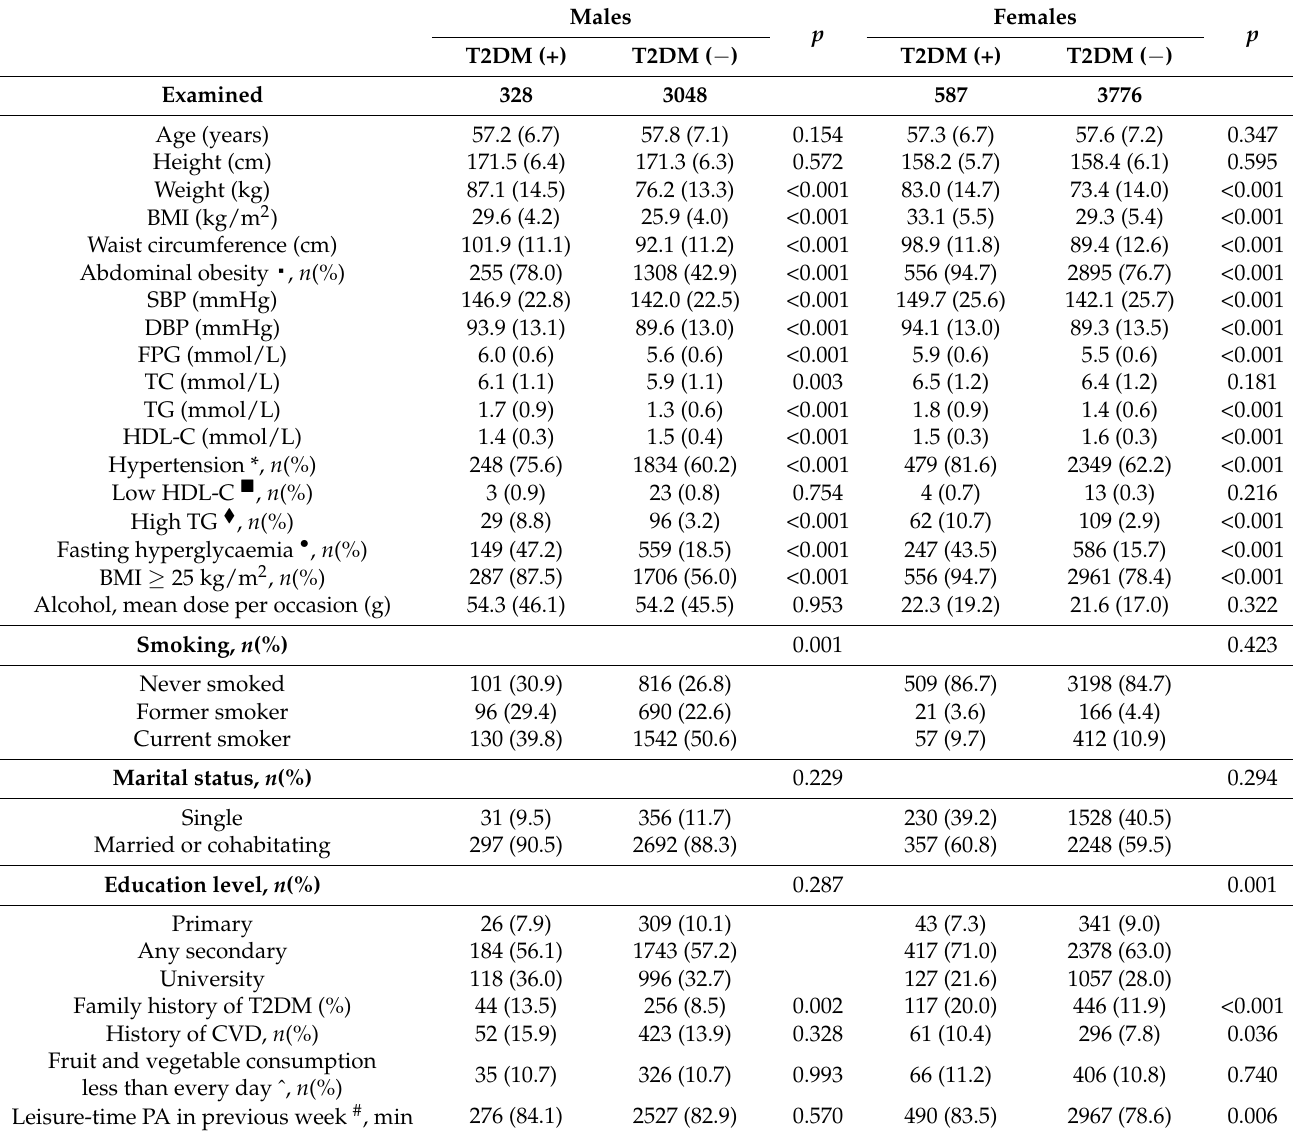
Table 1. Characteristics of the studied population sample (aged 45–69 years old at baseline, n = 7739). Table 2. Baseline characteristics of groups with incident T2DM and without T2DM stratified by sex (mean (SD), and n (%)). Males Females p